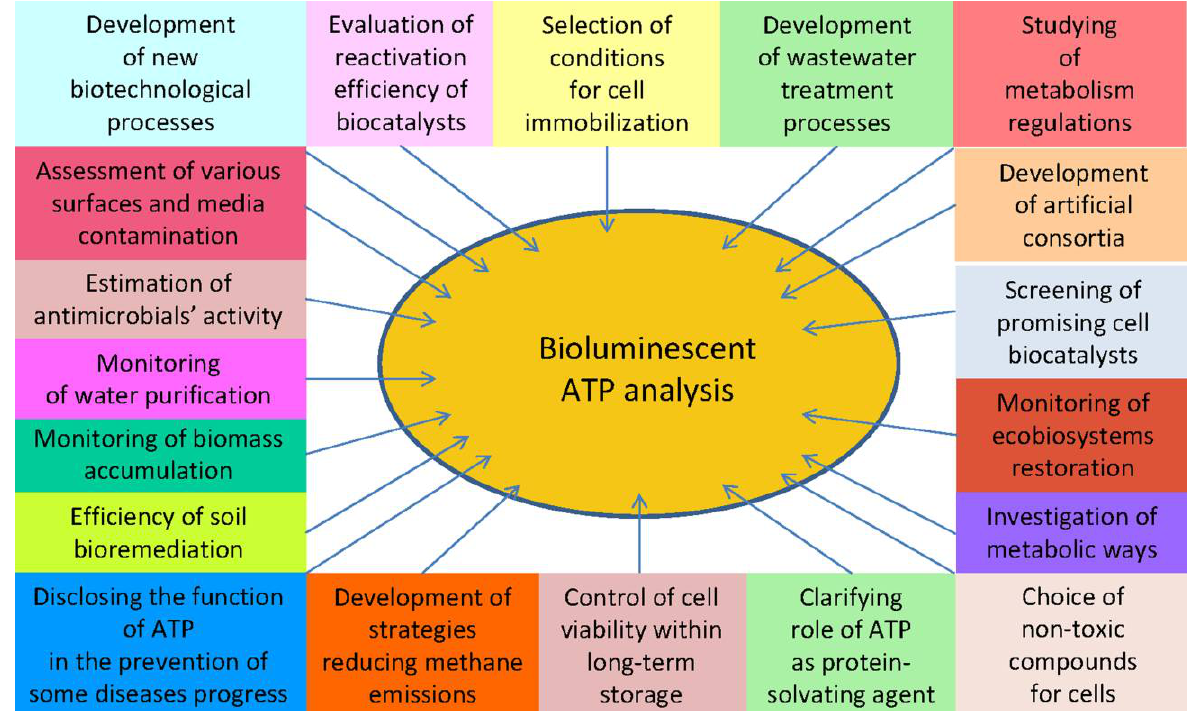
Figure 5. Generalizing scheme of recent applications of bioluminescent ATP-assay.